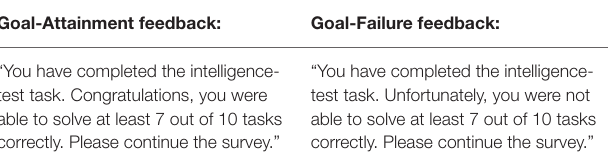
TABLE 1 | Fictitious feedback of goal-attainment/goal-failure in Study 1. Goal-Attainment